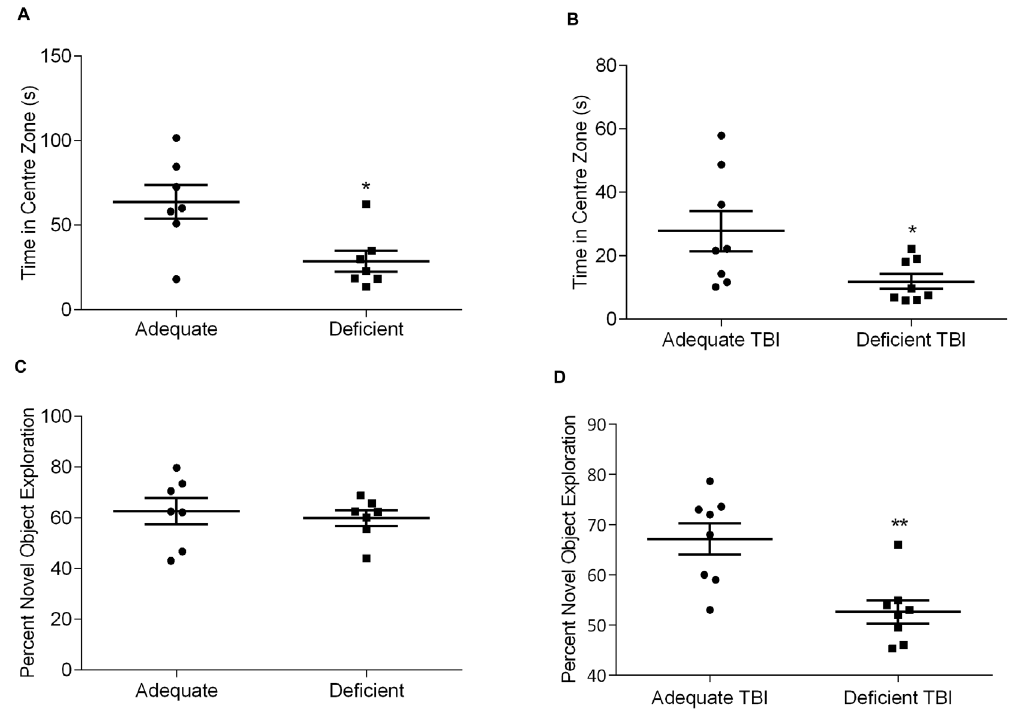
Figure 2. DHA depleted mice exhibit greater anxiety-like behavior and post-TBI memory deficits. (A) DHA deficient (Deficient) mice spend significantly less time in the centre zone of the open field than their DHA adequate (Adequate) counterparts (* p , 0.05 vs. Adequate), thus exhibiting anxiety-like behavior. (B) A similar pattern of exploration observed on day 5 after TBI (* p , 0.05 vs. Adequate TBI; n= 8). (C) No significant difference observed in novel object exploration time between the non-injured DHA adequate and deficient mice ( n= 7). (D) Significantly less exploration of the novel objects in DHA depleted mice on day 7 after TBI than their adequate counterparts (** p , 0.01 vs. Adequate TBI; n= 8).